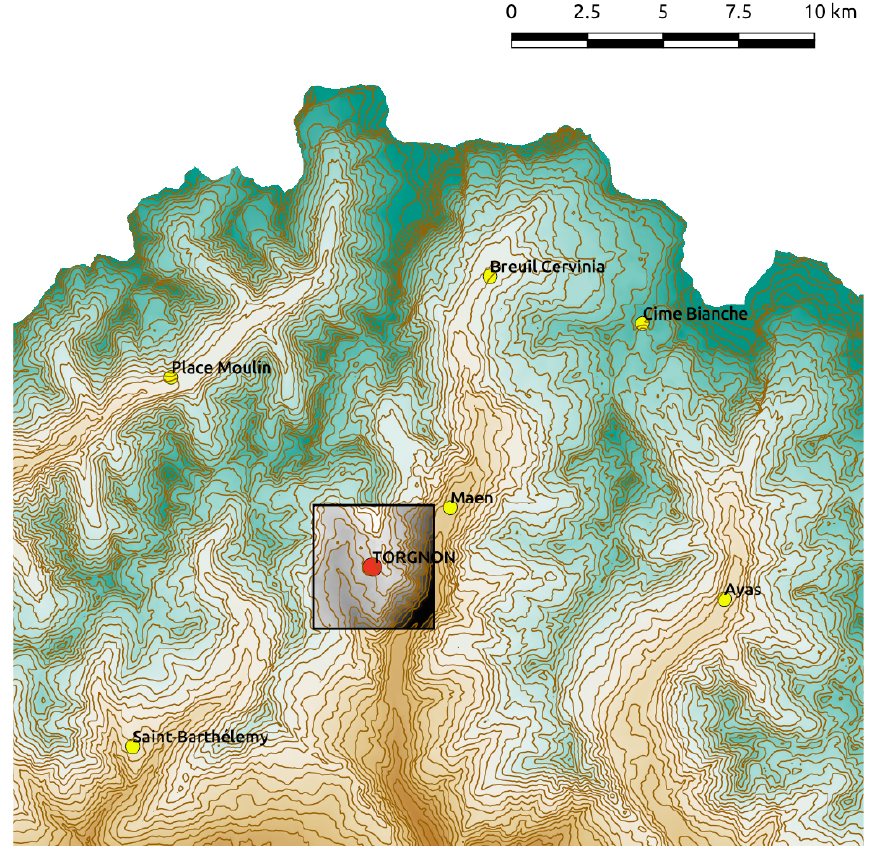
Figure B1. Locations of the six neighbouring stations used for producing the interpolated dataset for the MeteoIO experiment. The grey square represents the extent of the digital elevation model used for the